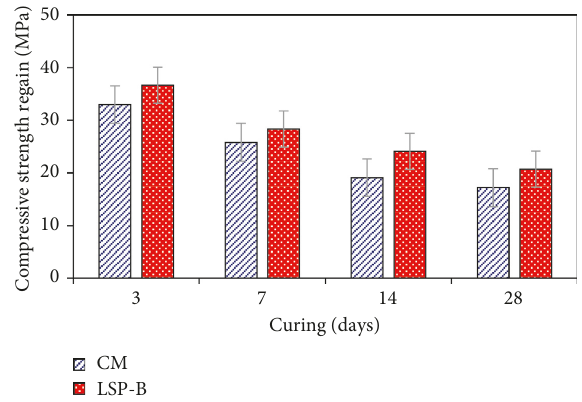
Figure 5: Compressive strength regain in mortar formulations with and without immobilized microbes at different precracking periods.